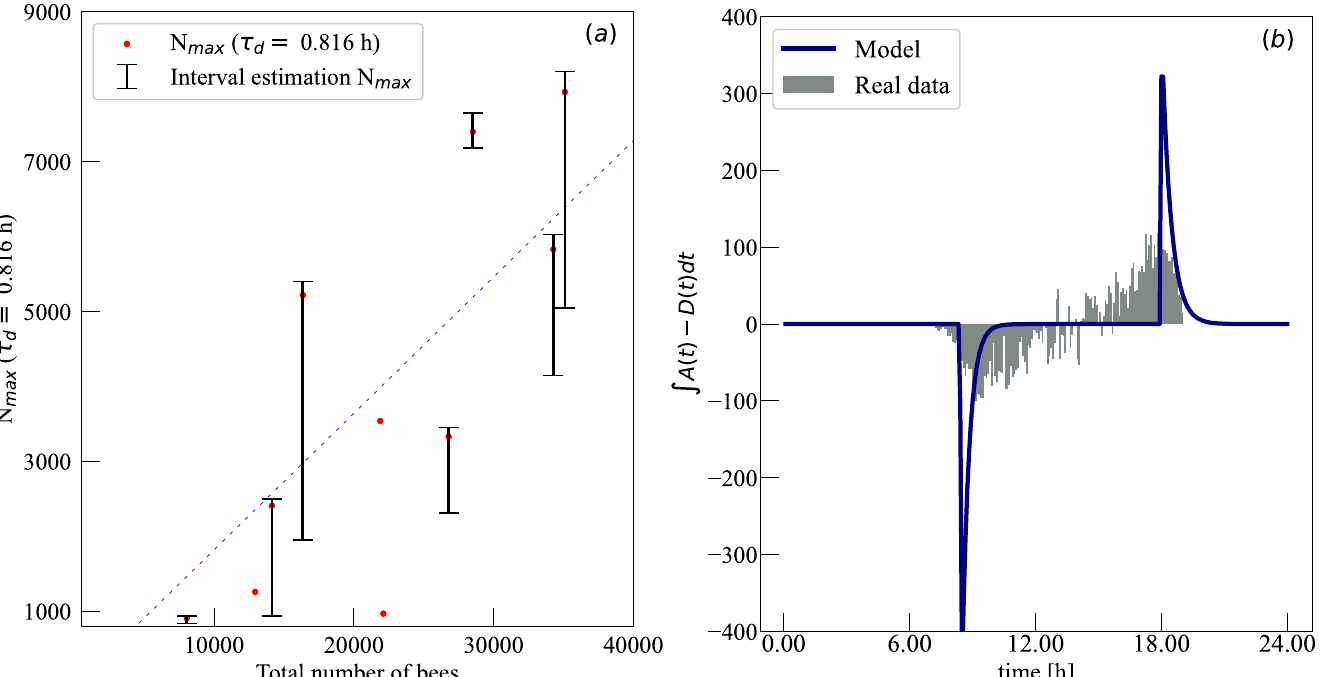
Fig 6. Comparing our model to independent measurements. (a) Our estimation of the number of active foragers N bees ( R 2 = 0.596, p = 0.036). The dashed straight line corresponds to 18.2% of all bees being foragers, constant across all hives. The total number of bees was estimated through an independent measurement performed on 2018–04-9, two days after the data used in our inference [34]. The points without bars correspond to those that had no successful interval estimation, as discussed in Table 2. In all our analysis of correlation between variables, the reported p-value p is the probability of obtaining a positive coefficient of determination R 2 equal or larger than the reported R 2 under the null hypothesis that the variables are independent from each other. (b) The plot represents the difference between the number of bees arriving and bees departing a honey-bee hive during a 5 minutes interval. The model prediction (blue line) was computed integrating A ( t ) − D ( t ) over each time interval. The real data was measured using bee-tracking methods.